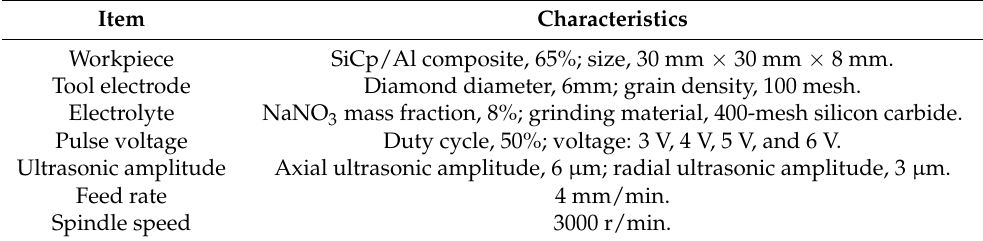
Table 2. Material parameters.